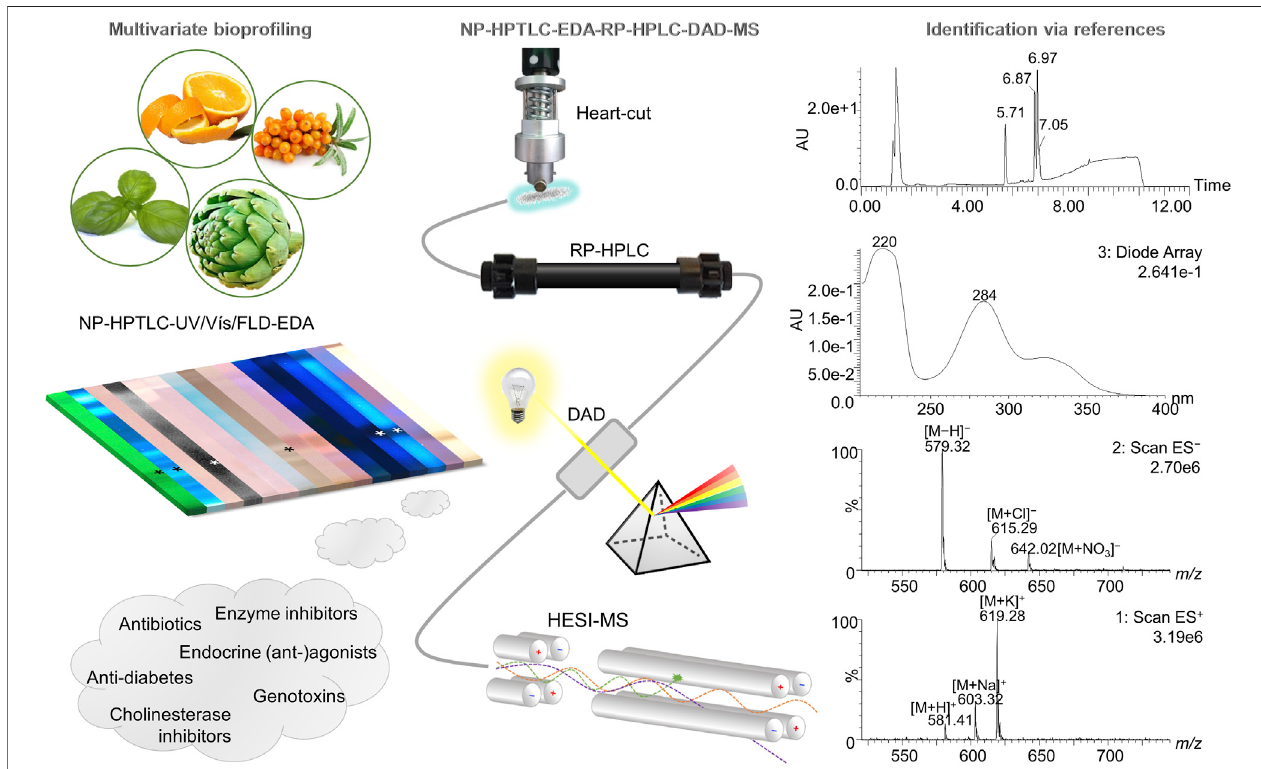
FIGURE 1 | Schematic overview of the hyphenation NP-HPTLC-UV/Vis/FLD-EDA-heart-cut RP-HPLC-DAD-HESI-MS. Botanical extracts were separated on NP- HPTLC plates followed by biochemical and microbiological detections. Bioactive zones were heart-cut eluted directly out of the (bio)autogram and transferred to the orthogonal RP-HPLC-DAD-HESI-MS, resulting in comprehensive information about a distinct bioactive compound.